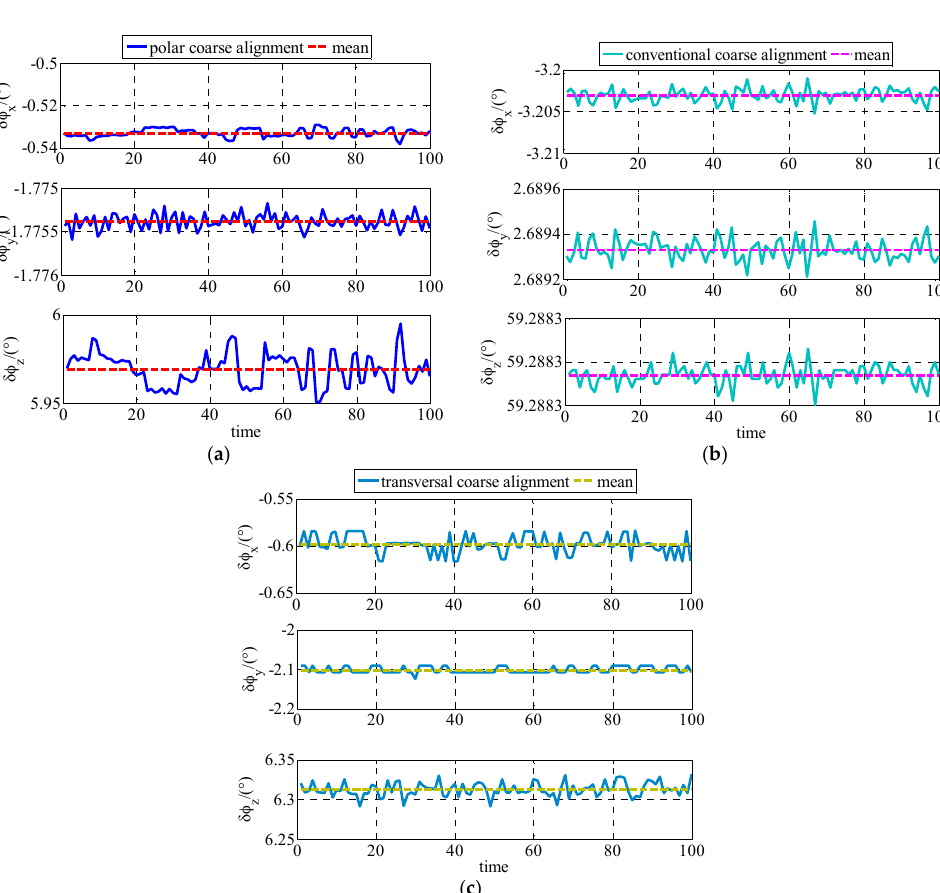
Figure 2. Estimates of φ G in simulation: ( a ) Estimates of φ G based on polar coarse alignment algorithm for polar UUV navigation; ( b ) Estimates of φ G based on conventional coarse alignment algorithm for polar UUV navigation; ( c ) Estimates of φ G based on transversal coarse alignment algorithm for polar UUV navigation.